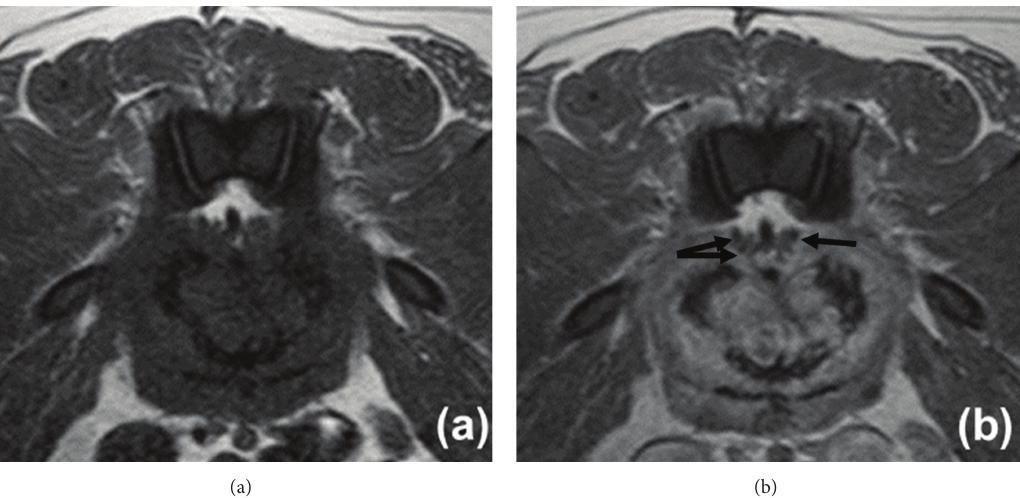
F 2: Transverse T1-weighted before (a) and aer (b) contrast MR imaging of the L6-7 intervertebral disk space. ere is strong contrast enhancement of the intervertebral disk and endplates suggestive of active diskospondylitis. Nerve root compression (hypointense circles as indicated by arrows) from the in�amed disk is also noted